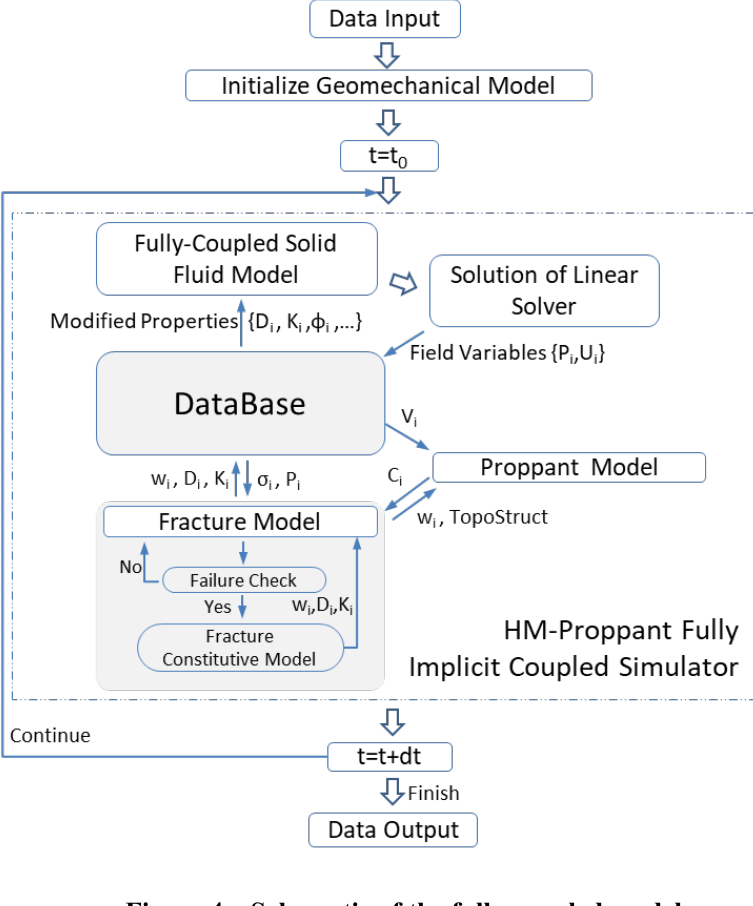
Figure 4—Schematic of the fully coupled